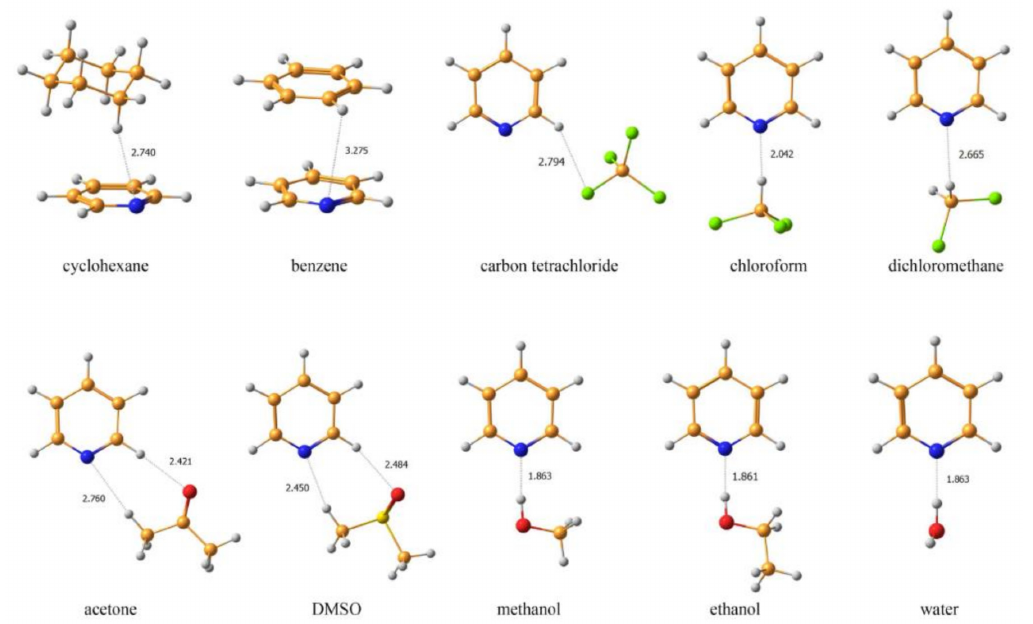
Figure 8. Equilibrium geometries of the SSM complexes of pyridine with different solvents optimized at the MP2/6- 311++G(d,p) level with taking into account bulk solvent effect within the IEF-PCM scheme. The most representative interatomic distances are given in Å. Reproduced from Semenov et al. [96] with the permission of John Wiley and Sons.